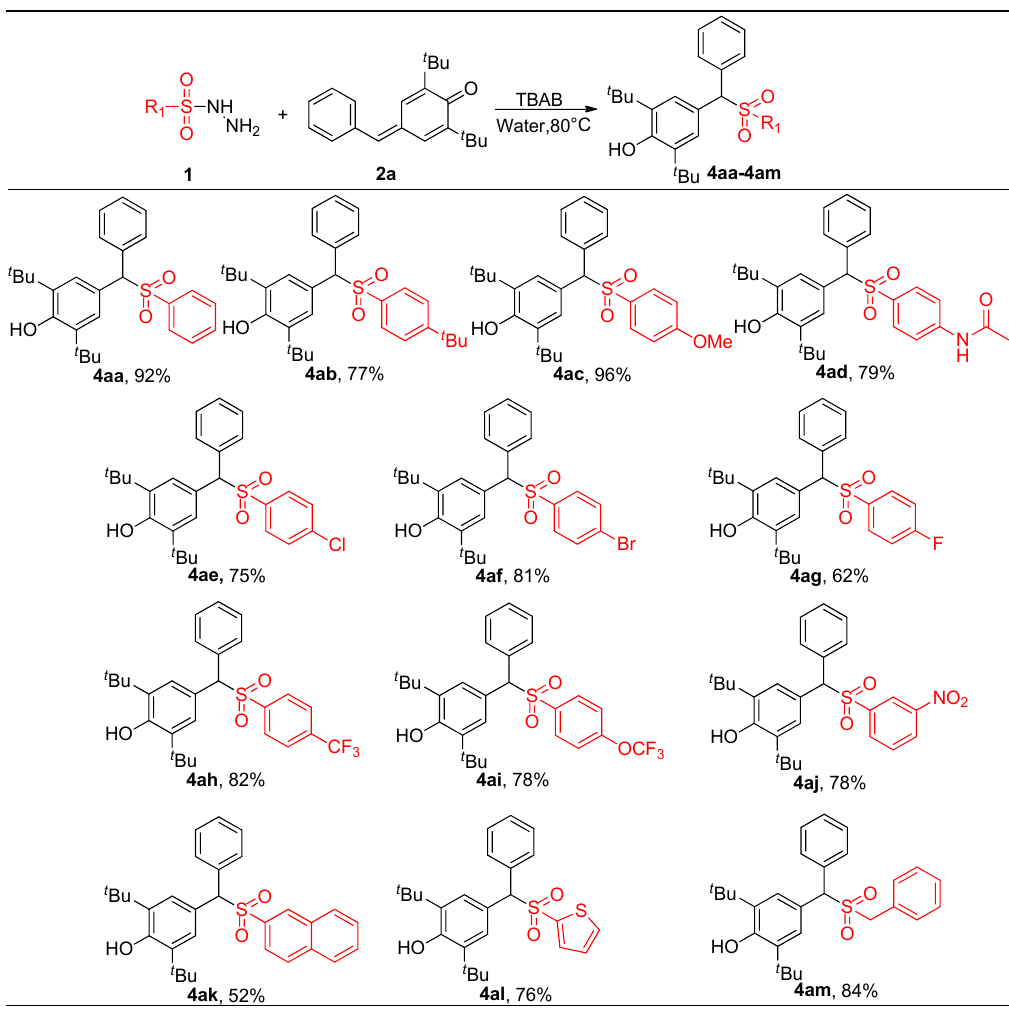
Figure 3. TBAB catalyzed 1,6-conjugate sulfonylation for synthesis of gem -diarylmethyl